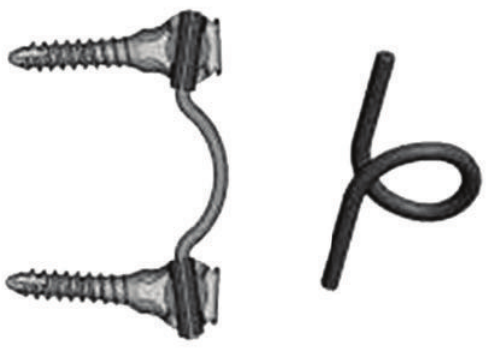
Figure 17: The DSS-I system.